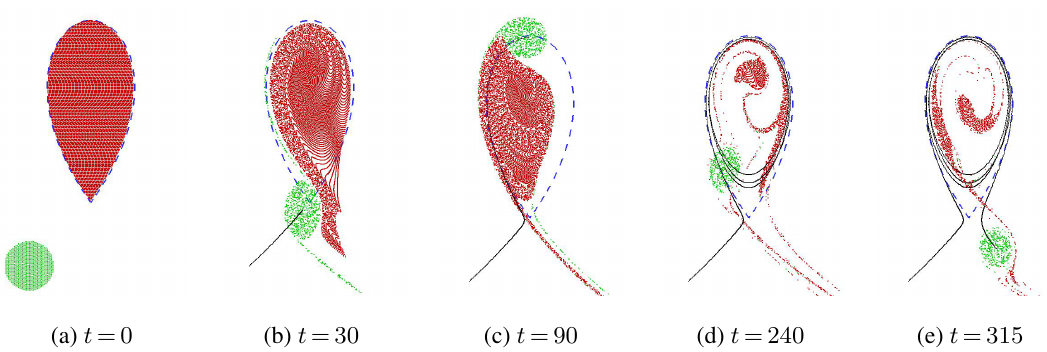
Fig. 11: Upper-layer monopole case. Particle scattering at the short-term monopole-topography interaction. Red and green markers correspond to the topographic and monopole vortex regions, respectively, the blue dashed curve is the unperturbed topographic vortex separatrix, and the black curve points out the trajectory of the monopole’s centre. Subfigures depict markers distribution at the corresponding instant in time.